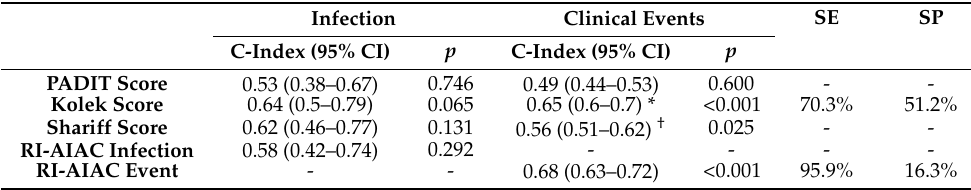
Table 7. Predictive ability of clinical scores in external validation